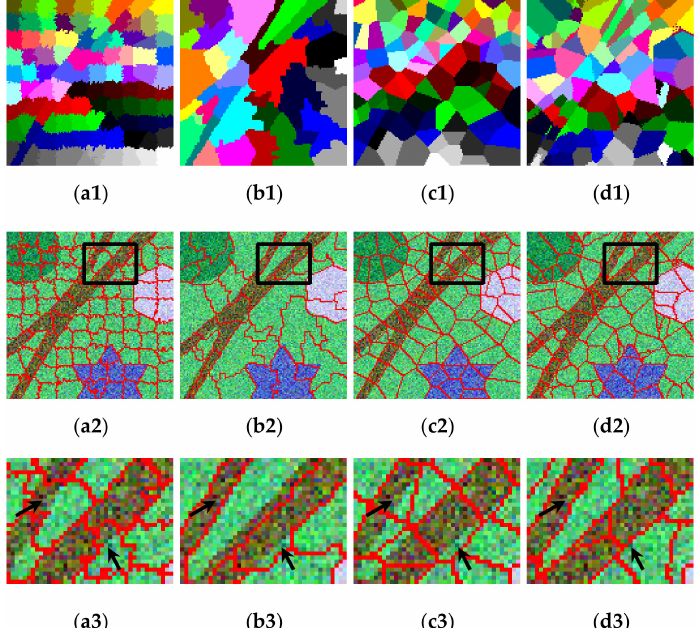
Figure 8. Visualization of the quality of sub-regions. ( a1 – a3 ) SLIC_FCM; ( b1 – b3 ) SF_FCM; ( c1 – c3 ) VT_HMRF_FCM; ( d1 – d3 ) The proposed